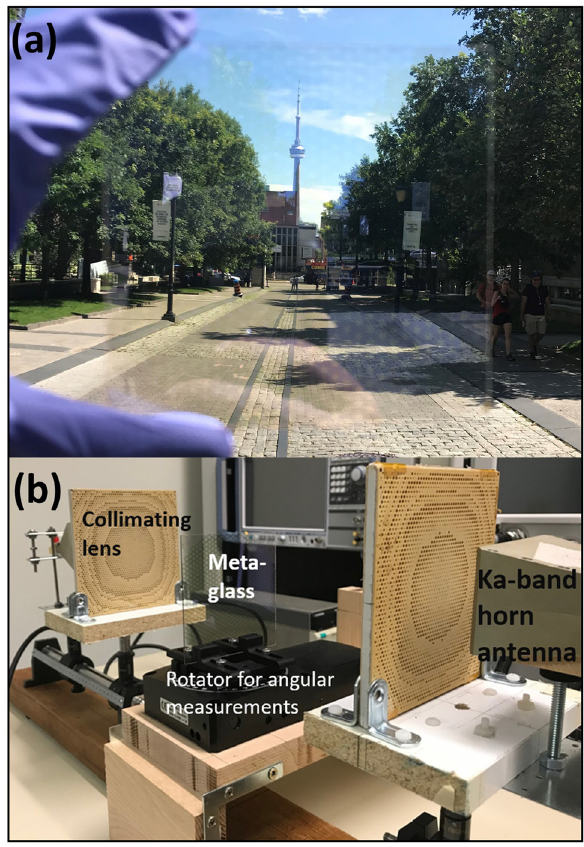
Figure 8: Photographs of (a) the fabricated optically and RF transparent meta-glass, and (b) the RF measurement apparatus.